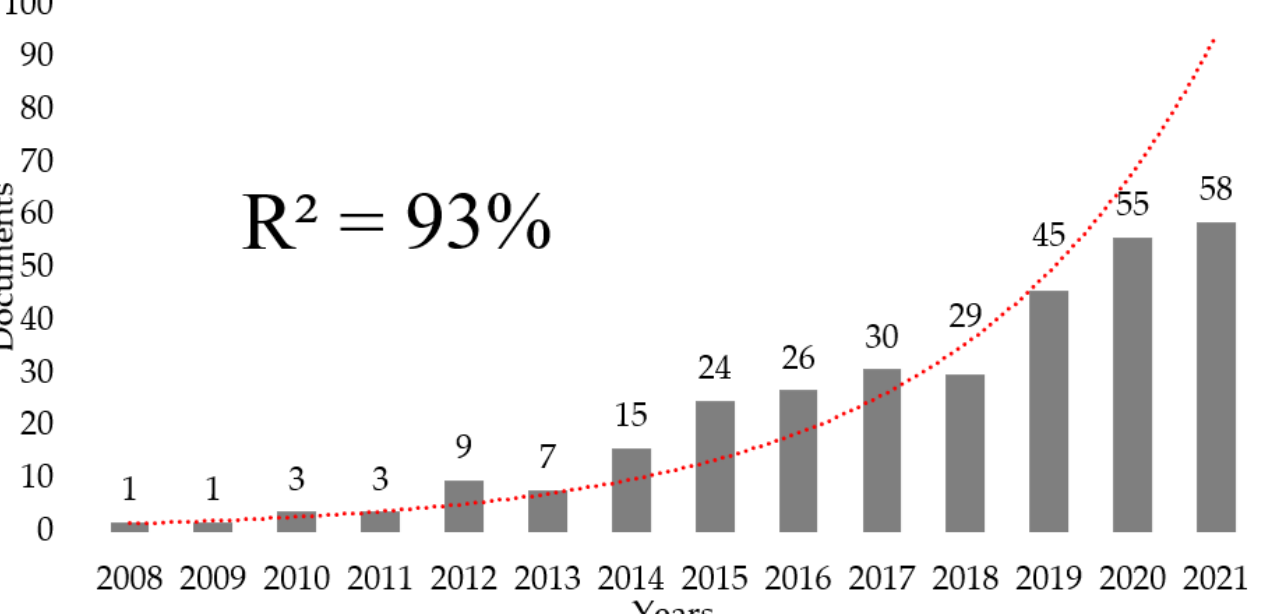
Figure 1. Graph showing the trend of annual publications on the topic.